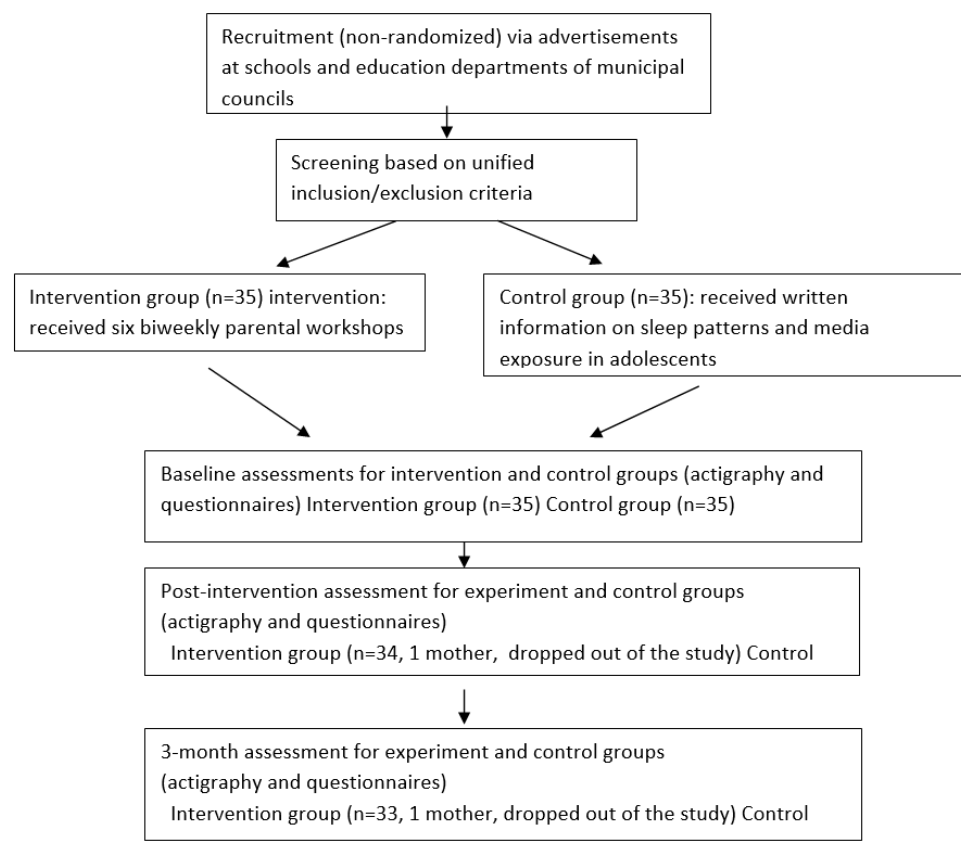
Figure 4. Flowchart of study procedures.